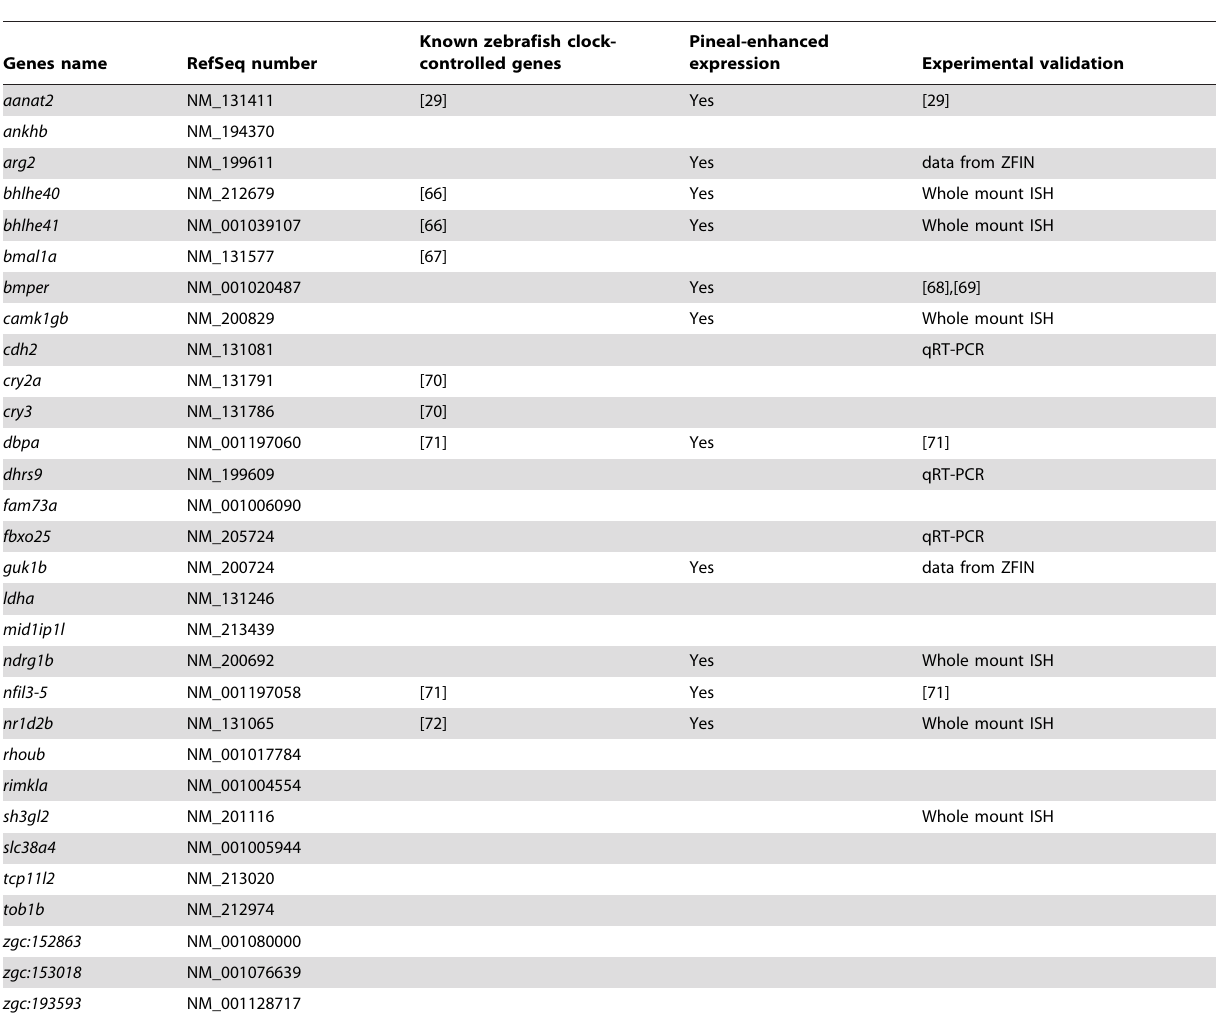
Table 1. Genes detected as circadian using both DNA microarray and